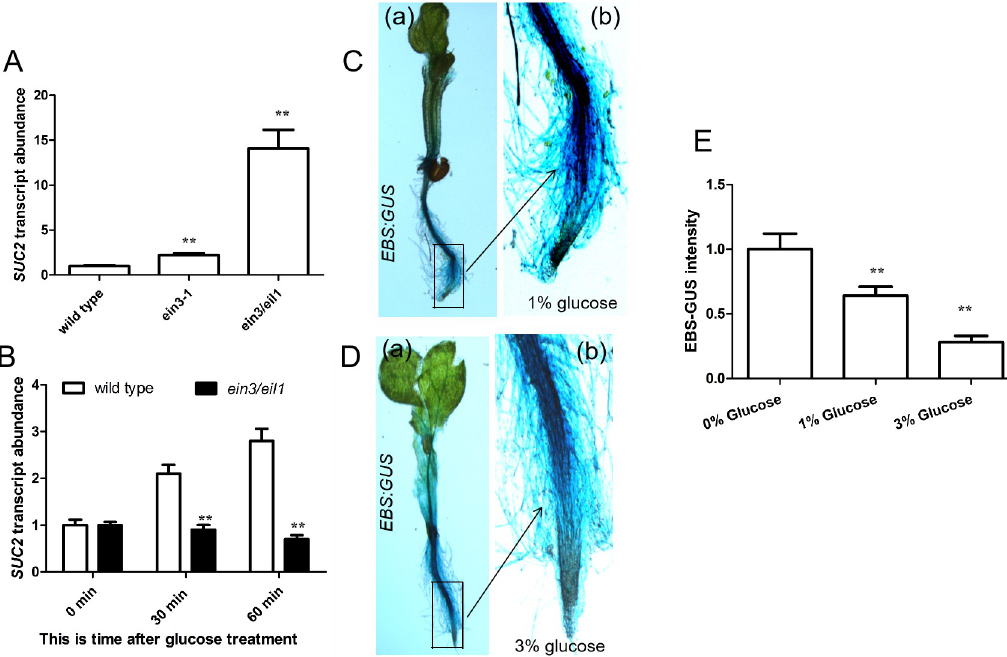
Fig 3. EIN3 negatively regulates SUC2 expression. A , Bar graph showing the differential expression of SUC2 among 5-day-old wild-type, ein3-1 and ein3/eil1 seedlings grown on MS medium with 1% glucose. Quantification of the expression of the SUC2 gene in wild-type seedlings was set as 1.0. B , Bar graph showing the differences in the expression level of SUC2 between wild-type and ein3/eil1 seedlings with different time treatment. Wild-type seeds were sowed and grown in soil for 10 days. And then these seedlings were gathered and treated with 2% glucose for 30 min and 60 min. Total RNA was extracted from these treated seedlings and qPCR was performed. Quantification of 10-day-old wild-type seedlings without treatment (control) is set as 1.0 in B. C and D , Images showing seedlings of EBS ( EIN3 binding site ) -GUS were grown on solid MS medium with 1% glucose (C) or 3% glucose (D) for 4 days in light, and then GUS staining was performed. (b) is amplified from the rectangle indicated in A/B (a). E , Bar graph showing intensity of EBS-GUS (C and D) quantified using Adobe Photoshop CS (Adobe Systems Inc., San Jose, CA) software, as described by Meng and Yao (2015). Quantification of 0% glucose is set as 1.0. Quantifications were normalized to UBQ5 expression in A and B. Error bars represent SD (n = 3). Student’s t test ( �� P <